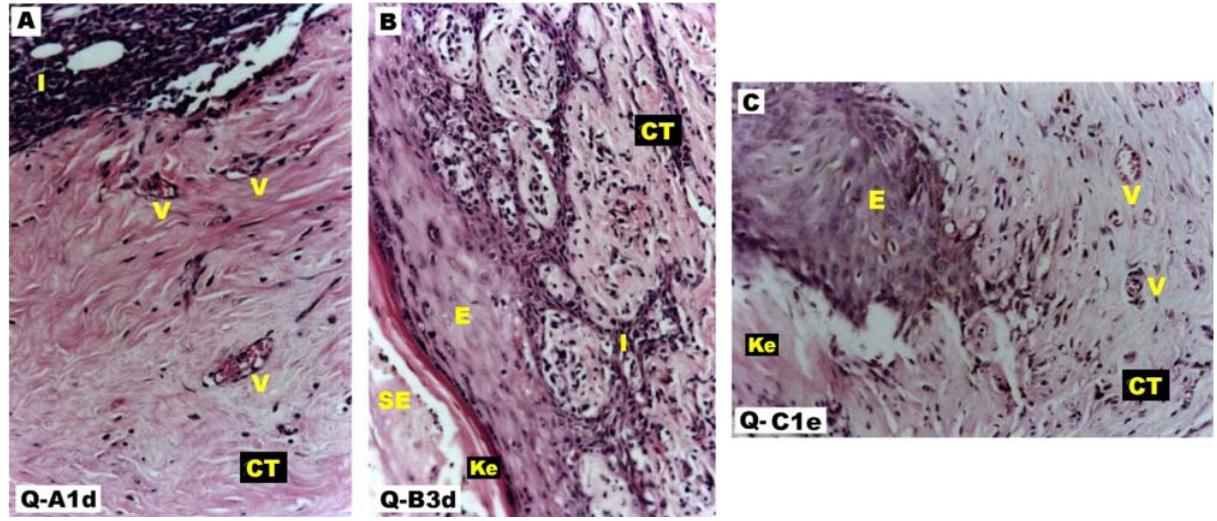
FIGURE 8 - Microscopic aspect of grafted keloid fragments up to 21 days (HE). A) At 5 days, presence of vascularized conjunctive tissue, with intensive mixed inflammatory tissue in the keloid periphery (x200). B) At 12 days, presence of whole epithelium, keratinized, with important inflammatory infiltrated in the peripheral and central regions of keloid (x200). C) At 21 days, presence of whole epithelium with keratin secretion and vascularized conjunctive tissue (x200). [E = Epithelium of the grafted fragment; SE = Sub-epithelium of the cheek pouch; Ke = Keratin; V = Blood vase in grafted fragment; I = Inflammatory infiltrated; CT = Conjunctive tissue].